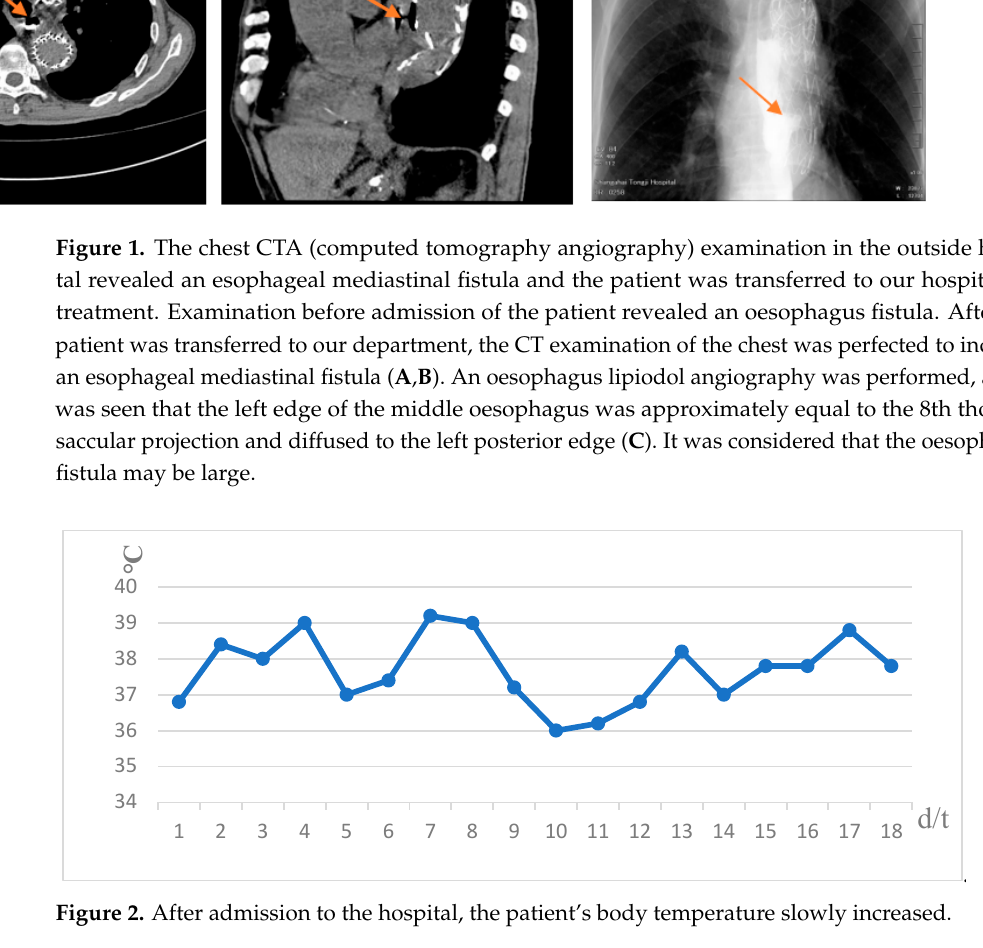
Figure 3. The patient developed intermittent hematemesis and the infection worsened. The patient’s blood routine examination showed that HB was lowered. After each blood transfusion treatment, the patient’s HB increased again ( C ). After the patient’s hematemesis was controlled, the re-exami- nation under the endoscopy was performed again, and no bleeding points were found. Then, a se- ries of inflammatory indicators were checked on the patient. The trend of changes in white blood cells (WBC) and neutrophils (N) after admission is basically consistent ( A ). After the patient was admitted to the hospital, the procalcitonin (PCT) increased significantly. After active treatment, the PCT improved significantly, but due to the continuous infection, the patient’s PCT testing increased again ( B ). The degree of changes in the red blood cell (RBC) to the haemoglobin (HB) in ( A ), after the patient is admitted, is mutually consistent ( C ). According to patients’ blood routine test results, acute infection was considered, and anti-infection was actively given for treatment. After anti-infec- tive treatment, blood routine, PCT and other detection indexes were significantly decreased . During the subsequent course, the patient was infected repeatedly. WBC, reference range (3.5 − 9.5) × 10 9 /L; N, reference range (1.8 − 6.3) × 10 9 /L; RBC, reference range (4.3 − 5.8) × 10 12 /L; PCT: reference range <0.05 ng/mL; HB, reference range (130–175) g/L).